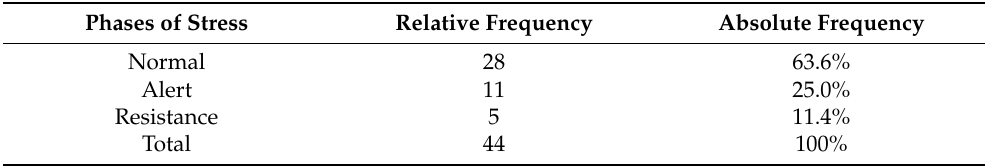
Table 5. Total frequency of the Phases of Stress in the participants, students from the 2nd year to the 9th year of the Basic Level of private schools in remote education in Santar é m, Par á , Brazil. Phases of Stress Relative Frequency Absolute Frequency Normal 28 63.6% Alert 11 25.0% Resistance 5 11.4% Total 44 100% Source: Data Bank of This Research.